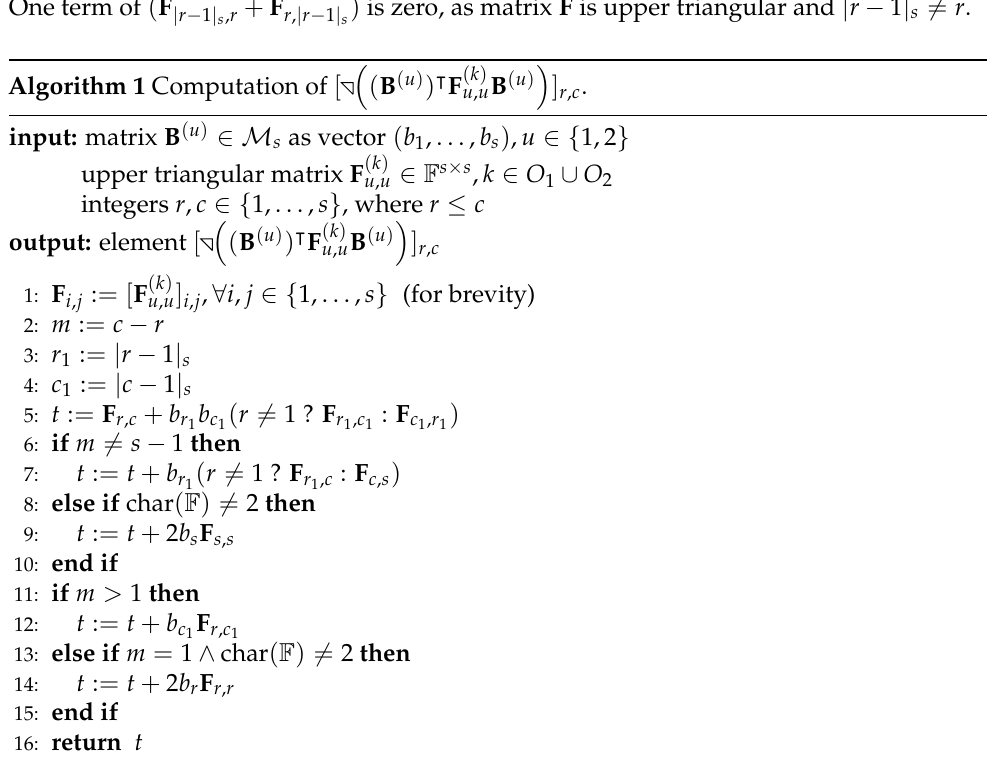
(cid:16) ( B ( u ) ) (cid:124) F ( k )